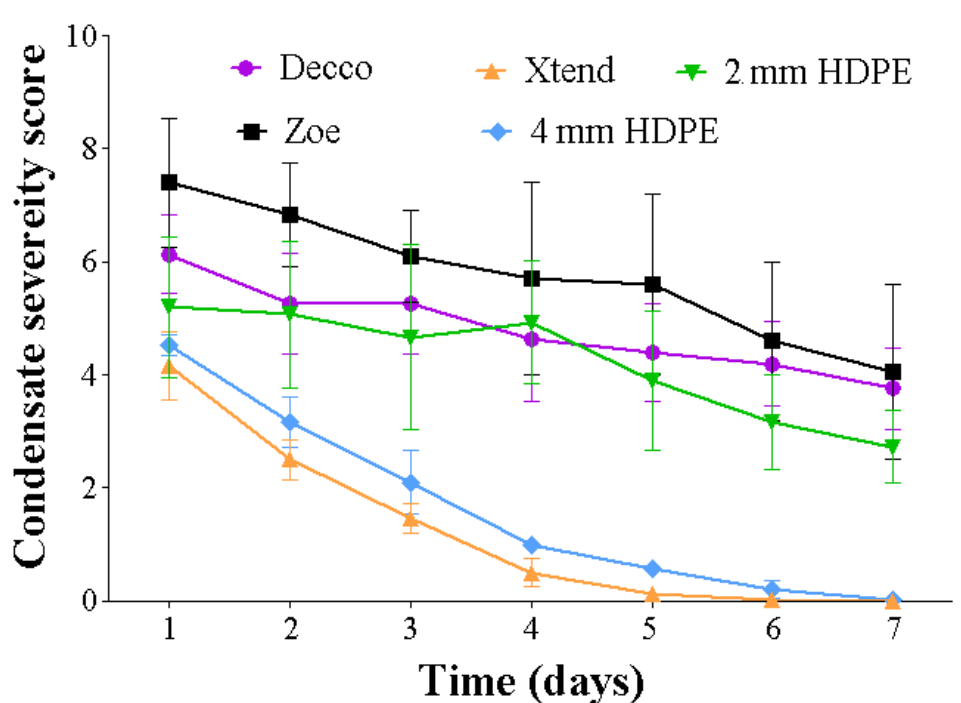
Figure 5. Variation of condensate inside liner bags, as depicted by 0 – 10 score scale (where 0 = none; 1 – 2 = trace; 3 – 4 = slight; 5 – 6 = moderate; 7 – 8 = severe; 9 – 10 = extremely severe). Pomegranate (cv. Wonderful) stored at 5 °C and 90% relative humidity (RH). HDPE: high density polyethylene.